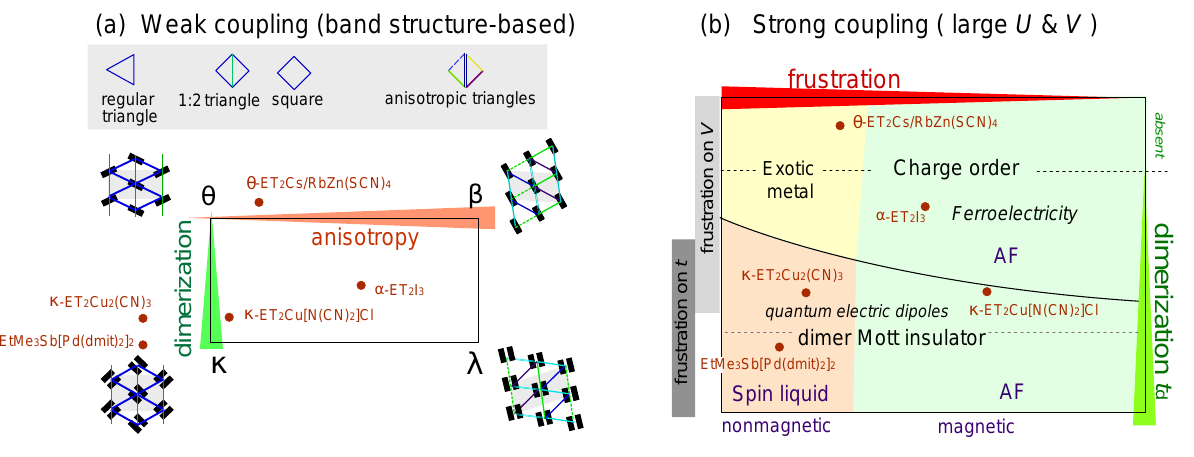
Figure 2. ( a ) The classification of quarter-filled electronic system in the weak-coupling regime. The θ and β -type with no (or weak) dimerization forms a triangular lattice in unit of molecule, whereas those with strong dimerization, κ - and λ -type do so in unit of dimer; ( b ) The overall sketch of the electronic states in the strong-coupling regime under frustration classified by the degree of dimerization, t . The axis of “anisotropy” of the crystals in ( a ) can d be approximately interpreted as a degree of geometrical frustration here, when one accounts for t and V along the nearest neighbor bonds along the crystal lattices, at under the weak and strong dimerization, respectively. (a) Weak coupling (band structure-based) (b) Strong coupling ( large U & V frustration